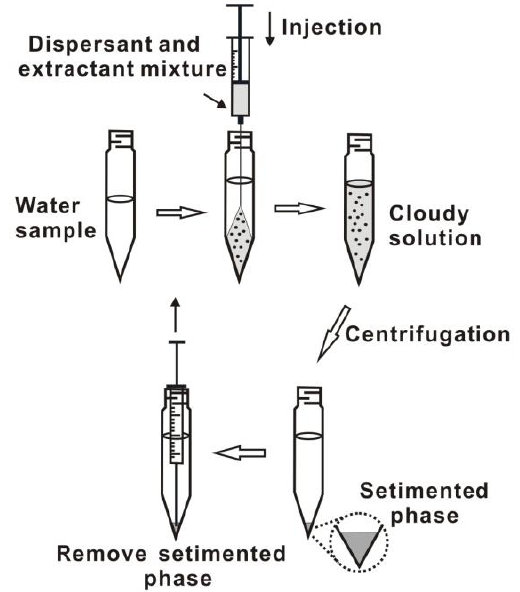
Figure 1. Dispersive liquid–liquid micro-extravtion (DLLME) operation schematic diagram.